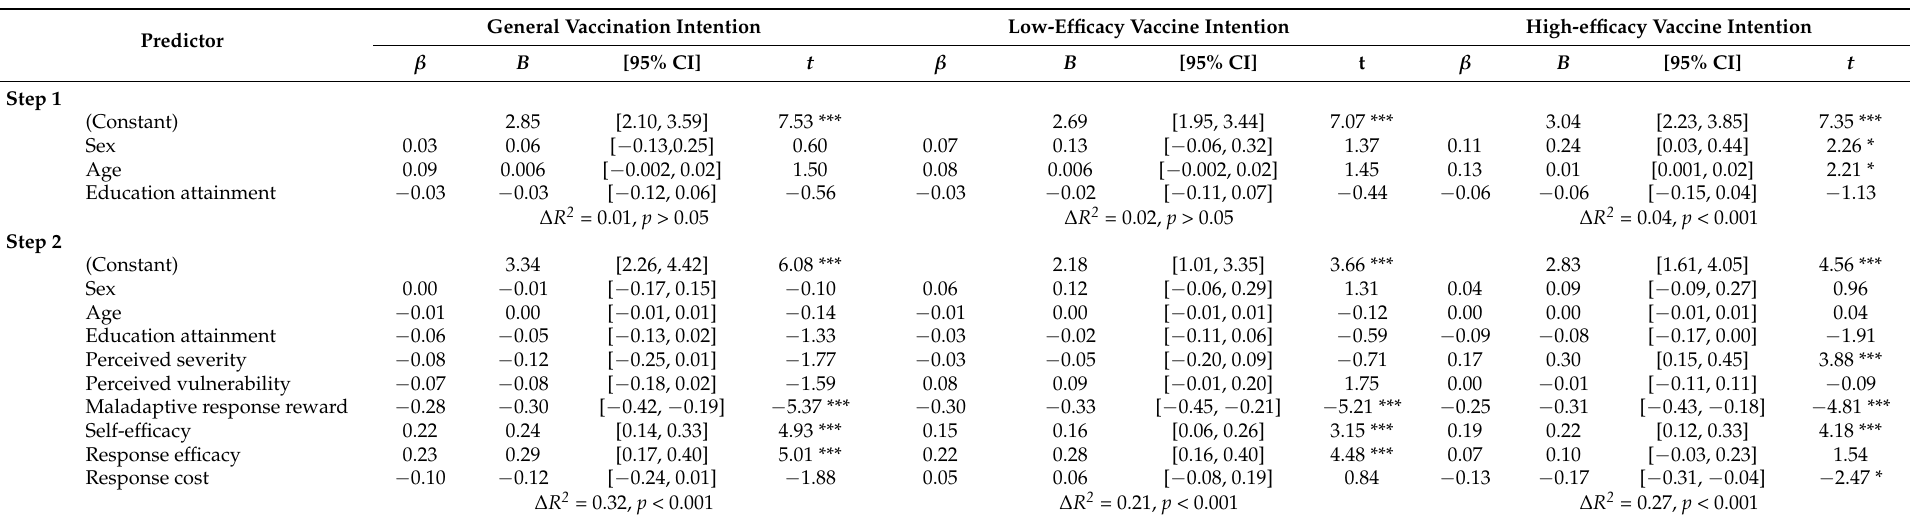
Table 3. Hierarchical regressions of intentions toward COVID-19